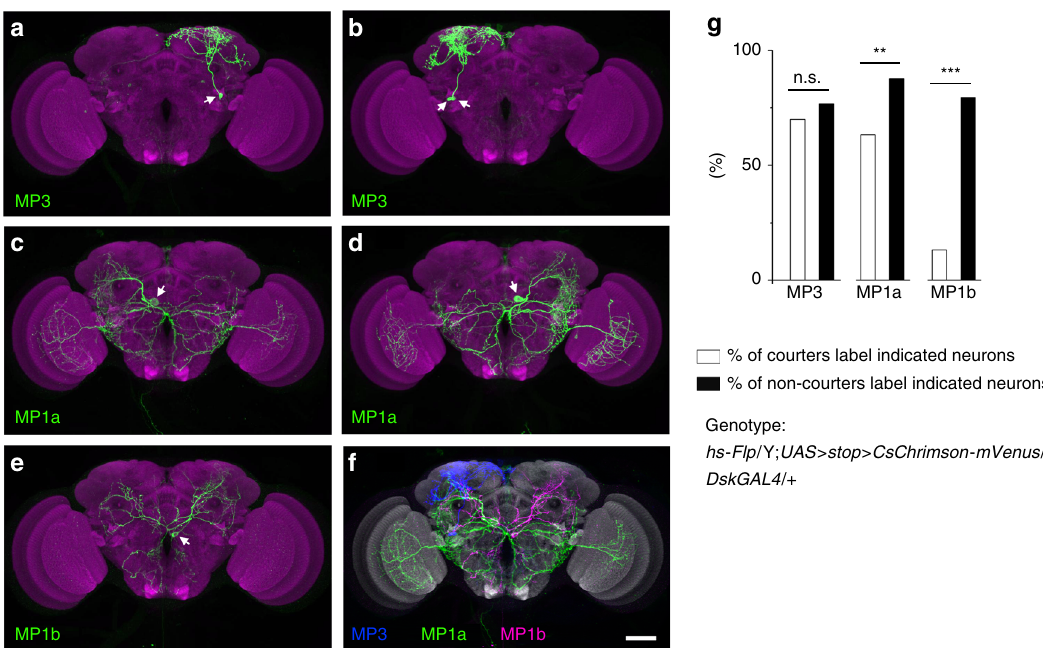
Fig. 3 Single-neuron labeling and manipulation of Dsk MP neurons. a – f Stochastic labeling of single MP3 ( a ), two MP3 ( b ), single MP1a ( c and d ) and single MP1b ( e ) neurons. Two MP3, one MP1a and one MP1b neurons are registrated in a standard brain ( f ). Scale bars, 50 μ m. g The frequency of hs-Flp/Y; UAS > stop > CsChrimson-mVenus/ + ; DskGAL4/ + males with CsChrimson-mVenus expressed in indicated neurons for courters ( n = 30, white bars) or n on- courters ( n = 73, black bars). ** p < 0.01, *** p < 0.001 and p = 0.48 (n.s.), chi-square test. n.s. not signi fi cant. Source data are provided as a Source Data fi